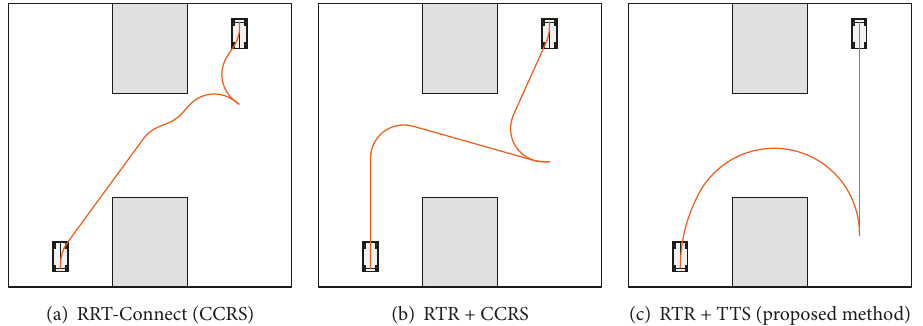
Figure 12: Path planning in a wide environment.